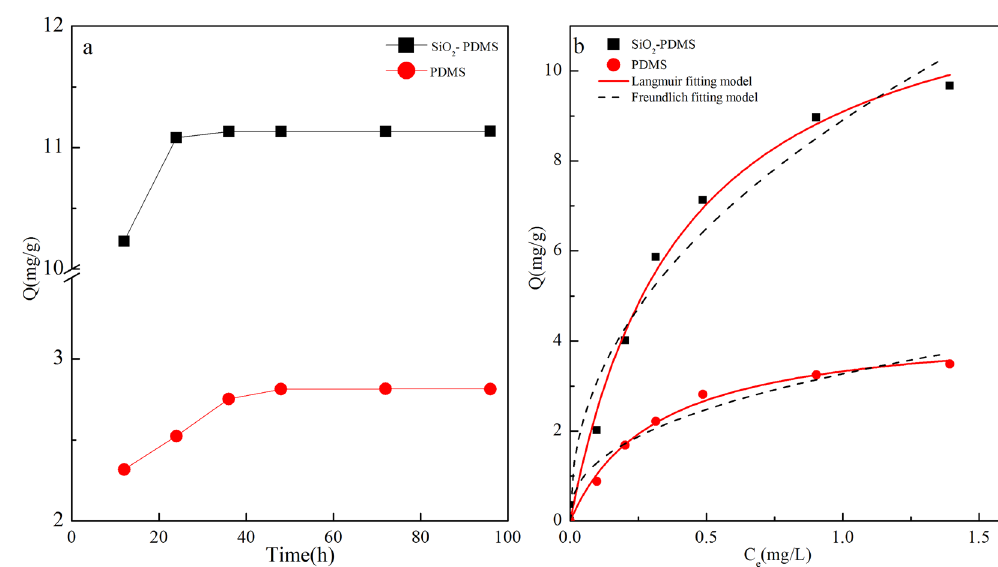
Figure 3. PhOH adsorption kinetics ( a ) and isotherms ( b ) on PDMS or SiO 2